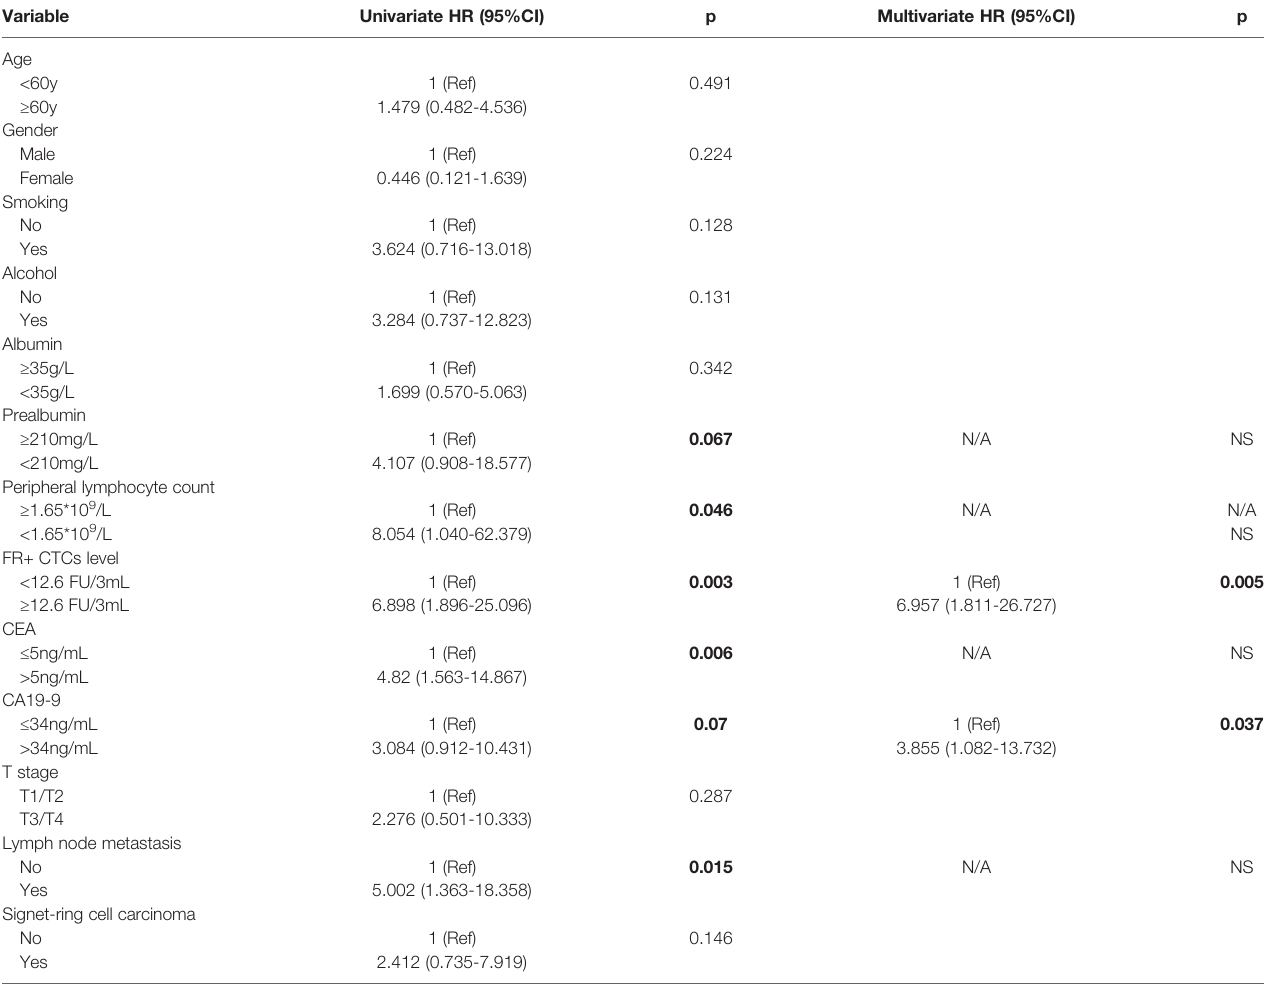
TABLE 4 | Univariate and multivariate Cox regression analyses predicting recurrence in gastric cancer patients after operation.